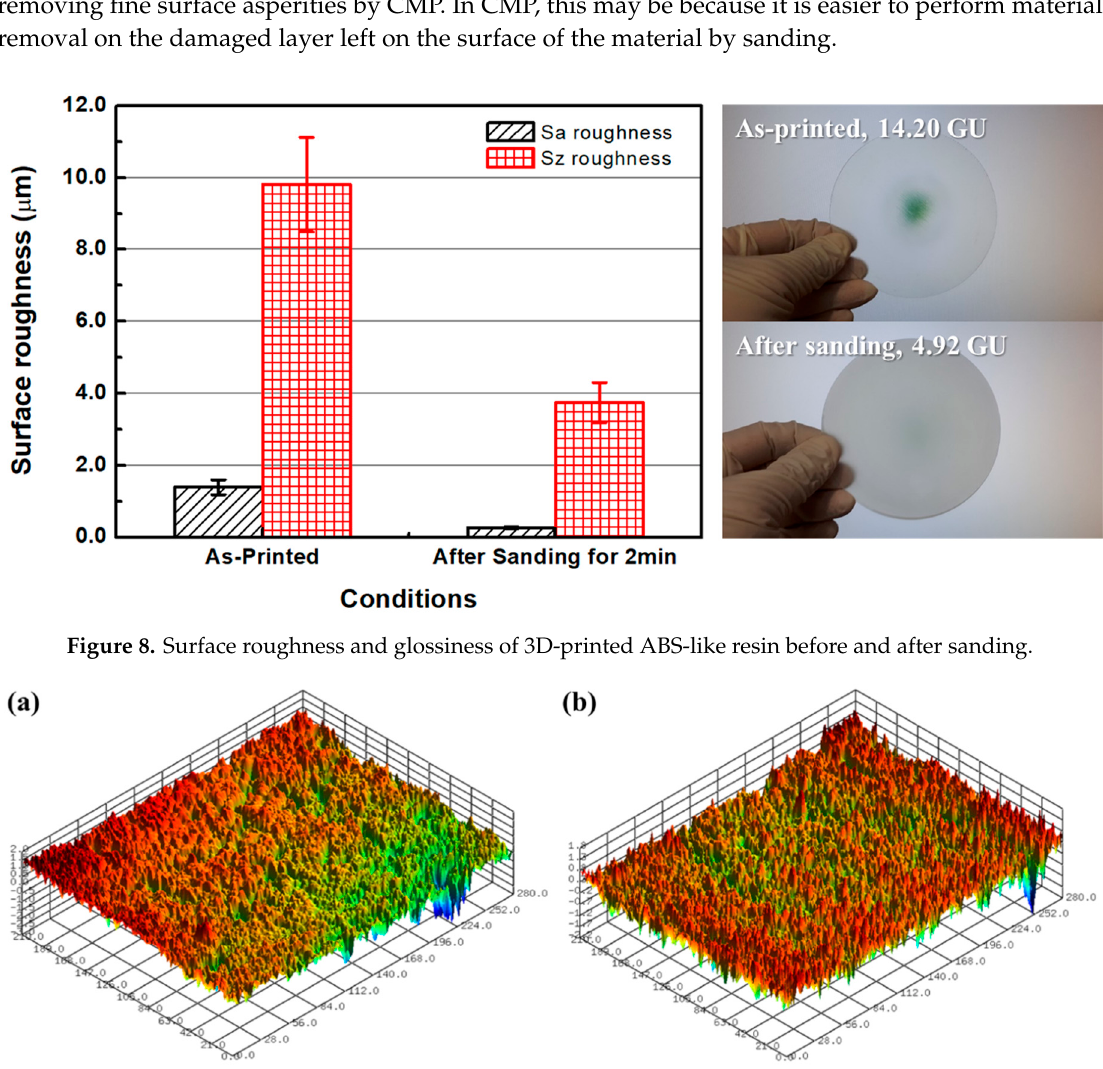
Figure 9. Representative surface profiles of SLA 3D-printed ABS-like resin after sanding for 2 min; ( a ) Sa of 0.256 μ m and Sz of 3.939 μ m ( b ) Sa of 0.241 μ m and Sz of 3.523 μ m.